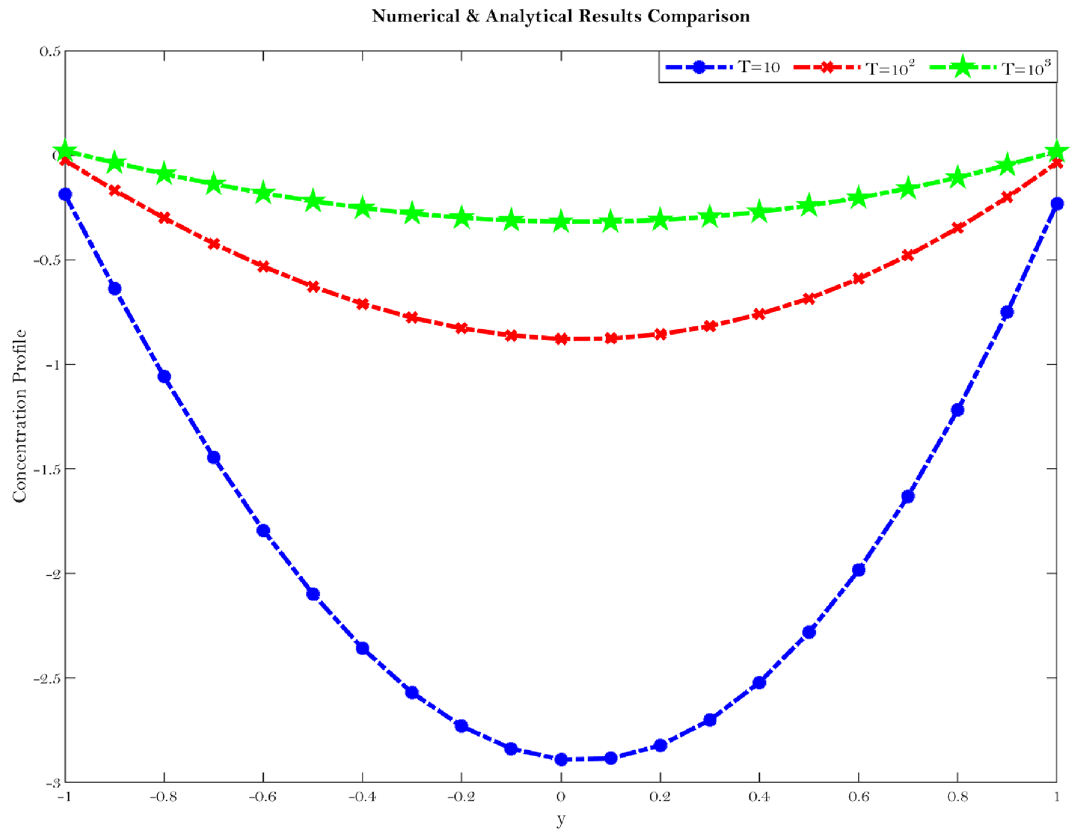
Figure 9. Shows concentration profile comparison at different value of the T